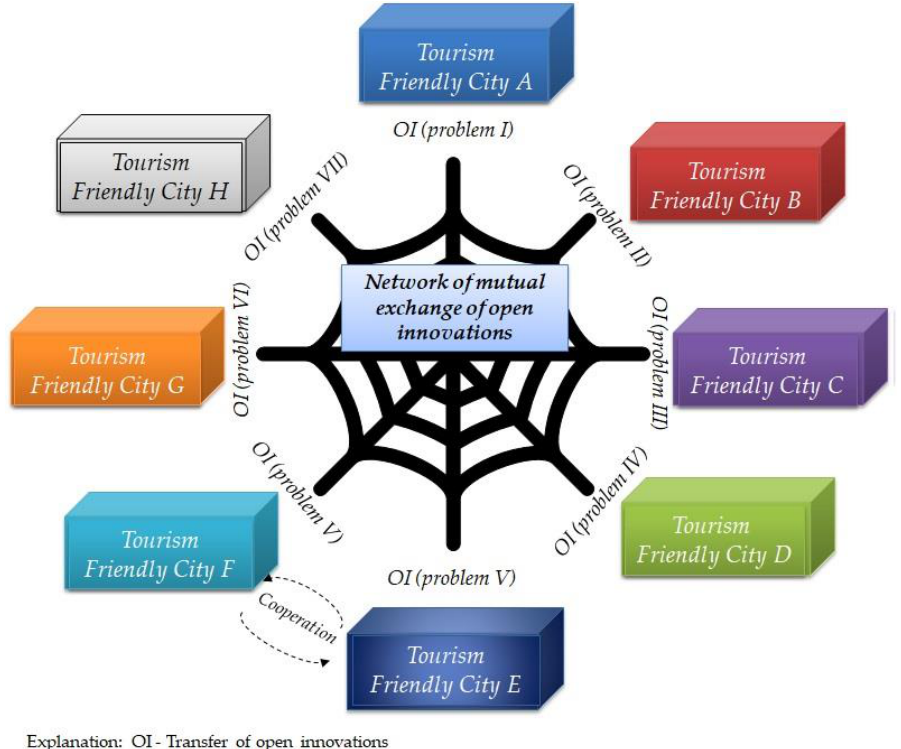
Figure 7. Network of mutual exchange of innovations open in the partnership of cities (tourism destinations). Source: Own study.